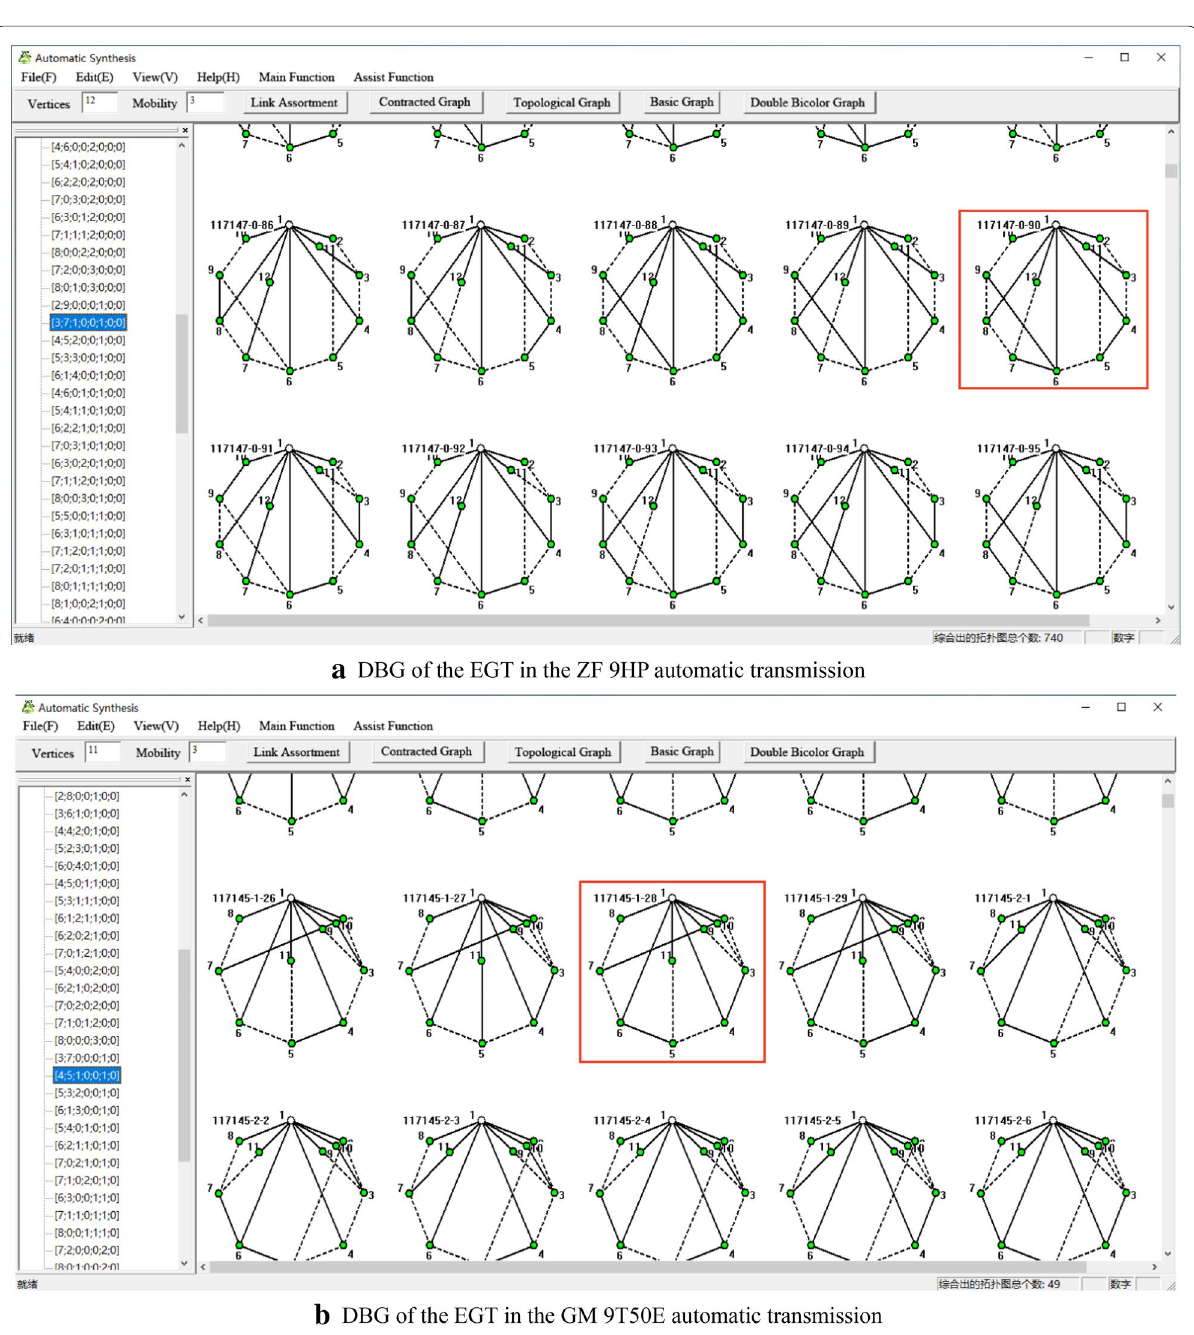
Figure 3 DBGs of EGTs in different automatic